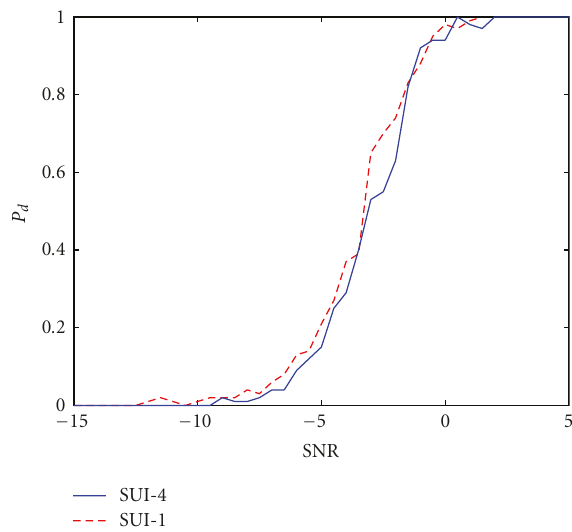
Figure 7: Probability of detection of a CP-OFDM signal through SUI-1&4 channels models with AWGN.